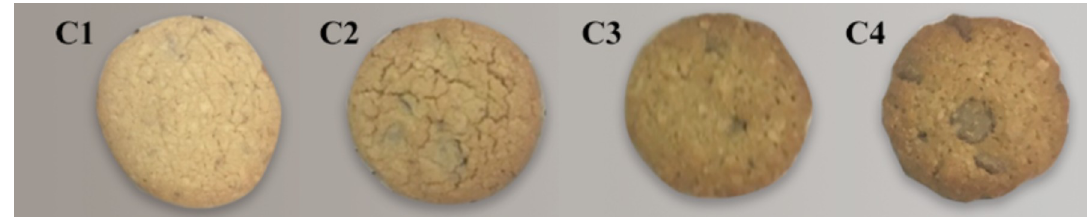
Fig 2. Xiquexique cookies. C1—wheat flour cookies (control1), C2–50% xiquexique flour (100 mesh) cookies, C3—whole wheat flour cookies (control2) and C4–50% whole xiquexique flour (28 mesh)